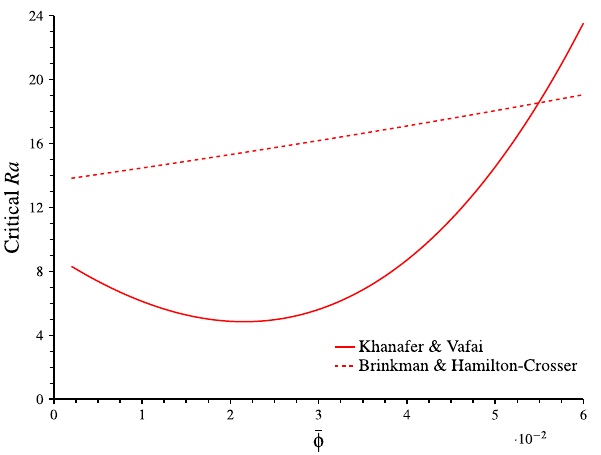
Figure 4: The relation between the volume fraction of nanoparticles and the critical thermal Rayleigh number for DW/cupric oxide nano fl uid based on the model of Khanafer and Vafai and the model of Brinkman and Hamilton - Crosser.